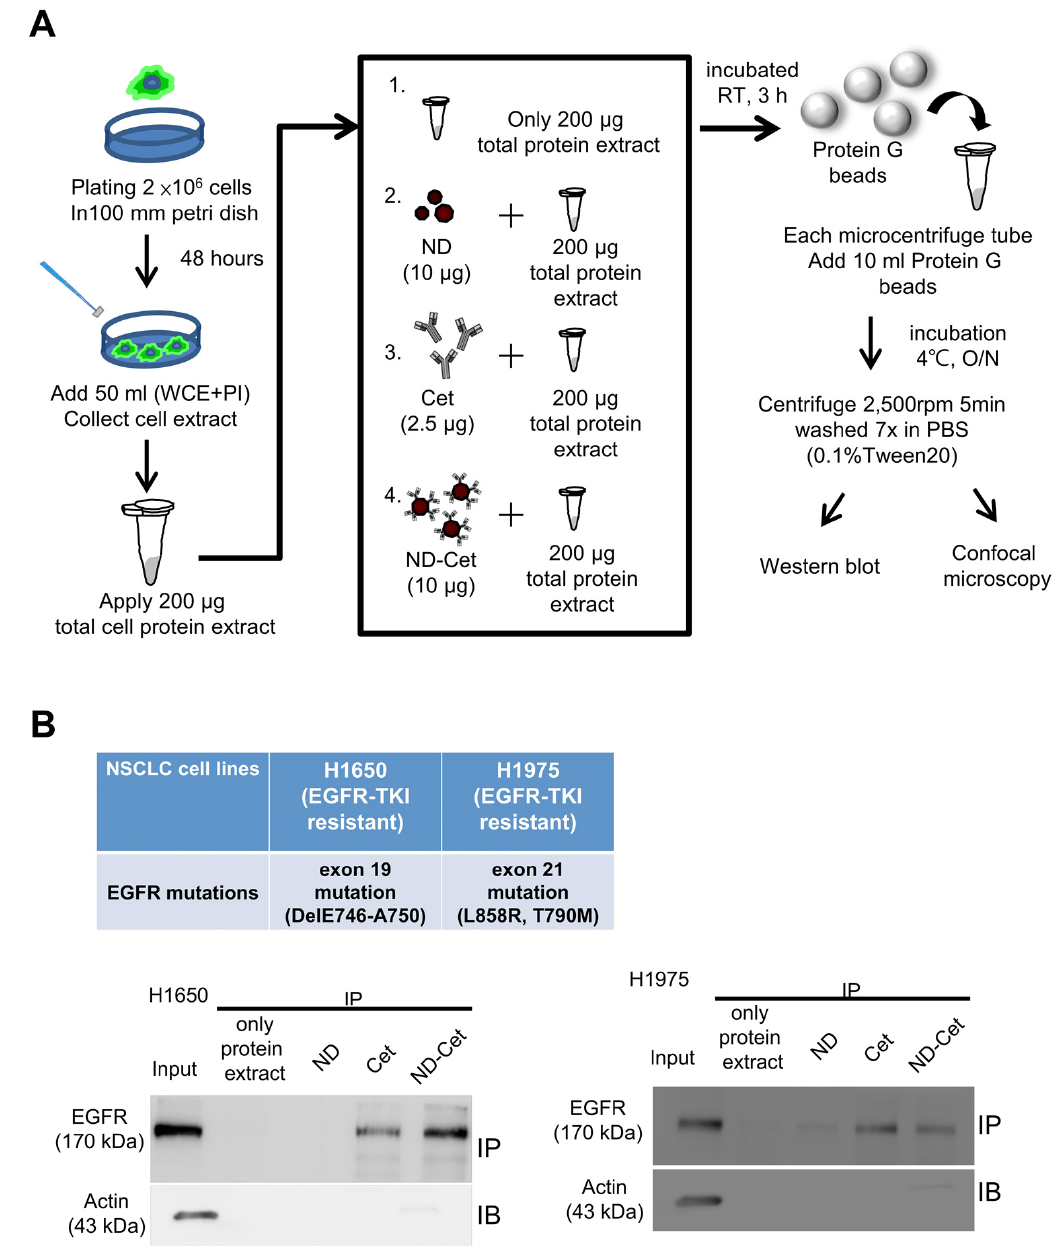
Figure 5. ND-Cet selectively pulled down EGFR proteins of lung cancer cells. ( A ) The immunoprecipitation protocol is to detect EGFR by ND-Cet. The total cellular protein extracts were mixed with Cet (2.5 µg), ND (10 µg), and ND-Cet (10 µg), then incubation at room temperature with continuous mixing for 3 h. The Protein G SepharoseTM beads were added to each sample. ( B ) ND-Cet selectively pulled down EGFR in H1650 and H1975 lung cancer cells with EGFR mutations. Immunoprecipitation of H1650 and H1975 cells using 200 µg cell lysate, 10 µg ND, 2.5 µg Cet, and 10 µg ND-Cet. The EGFR proteins were immunoprecipitated using Cet and ND-Cet. The protein levels were examined by westernblot analysis using specific antibodies. The above representative immunoprecipitation and western blot data were shown from one of three separate experiments with similar